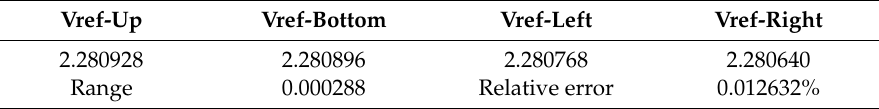
Figure 18. Signal readout and conditioning circuit. Table 4. Results of the reference voltage test in four